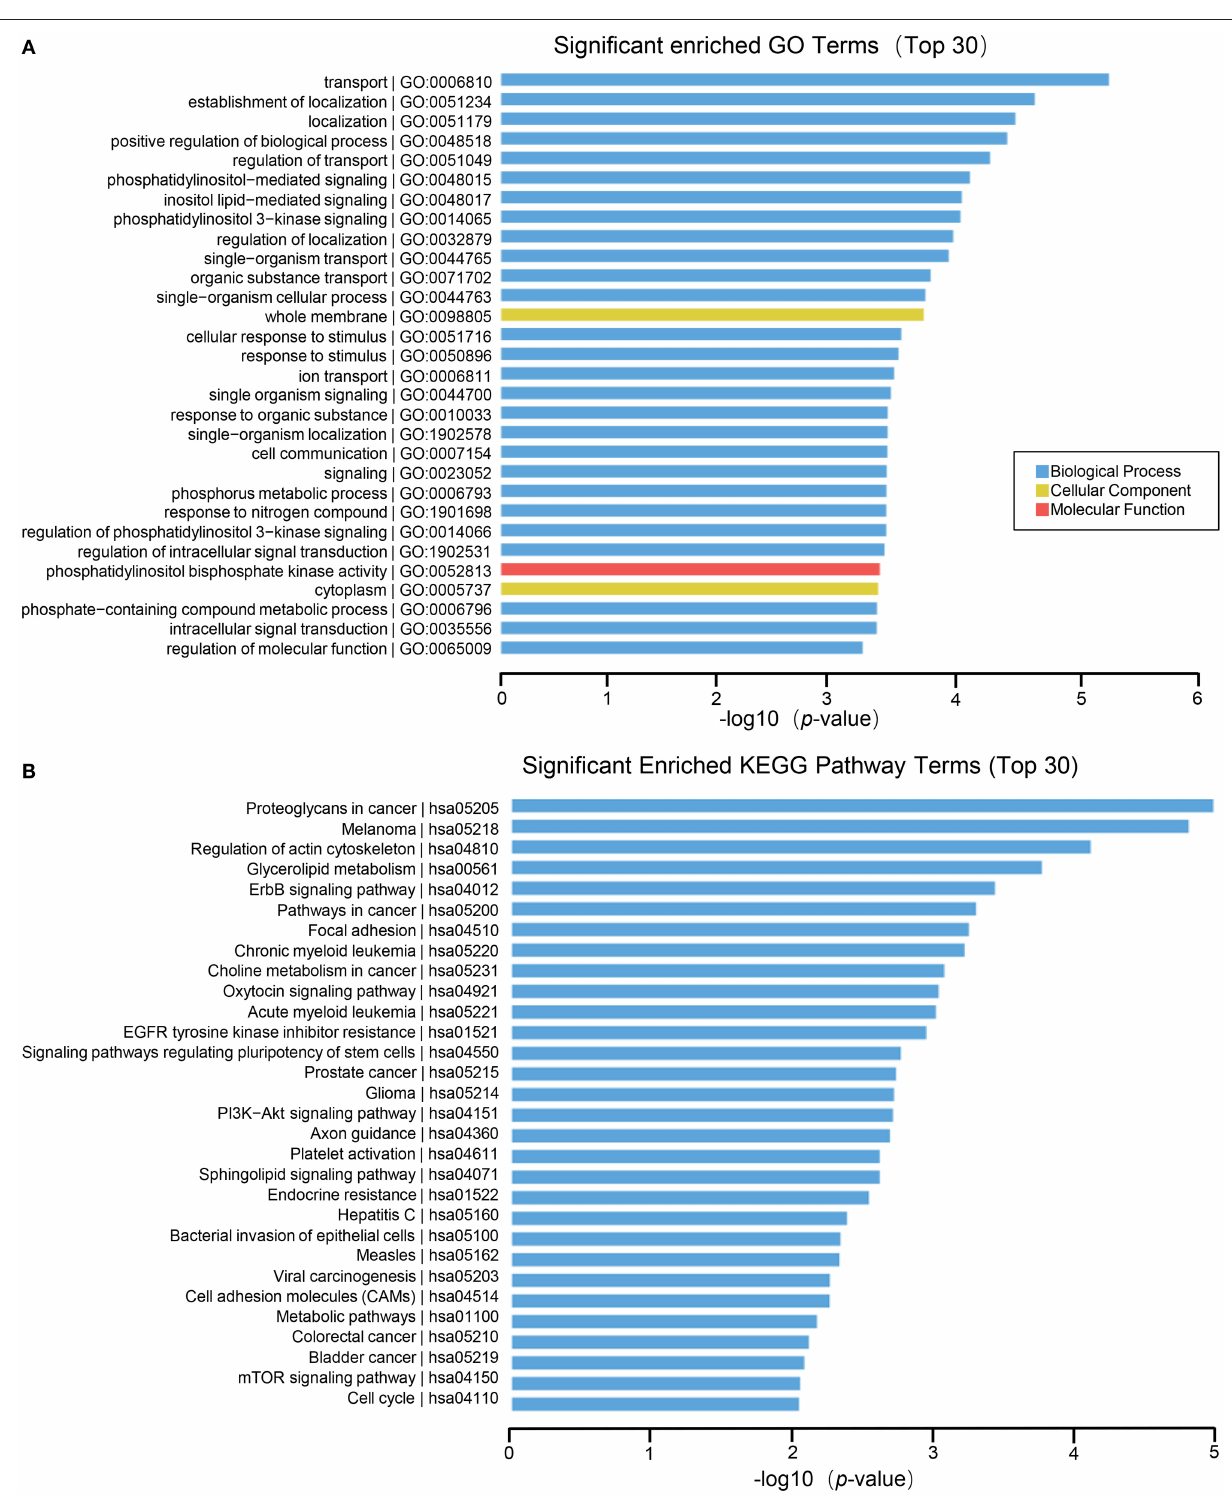
Frontiers in Neuroscience |